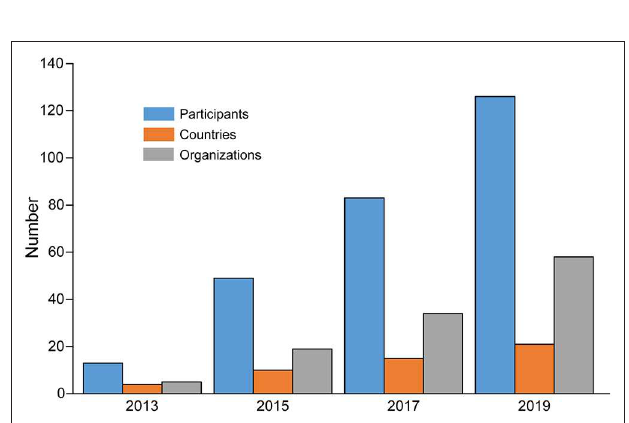
FIGURE 7 | Growth of the network over time, showing the cumulative number of participants, countries, and organizations from 2013 to